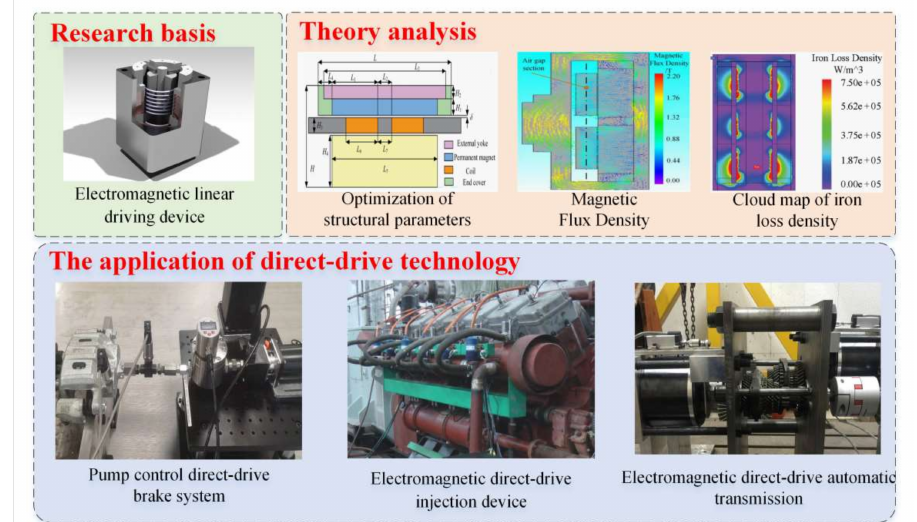
Figure 6. The theory analysis and application of direct-drive technology